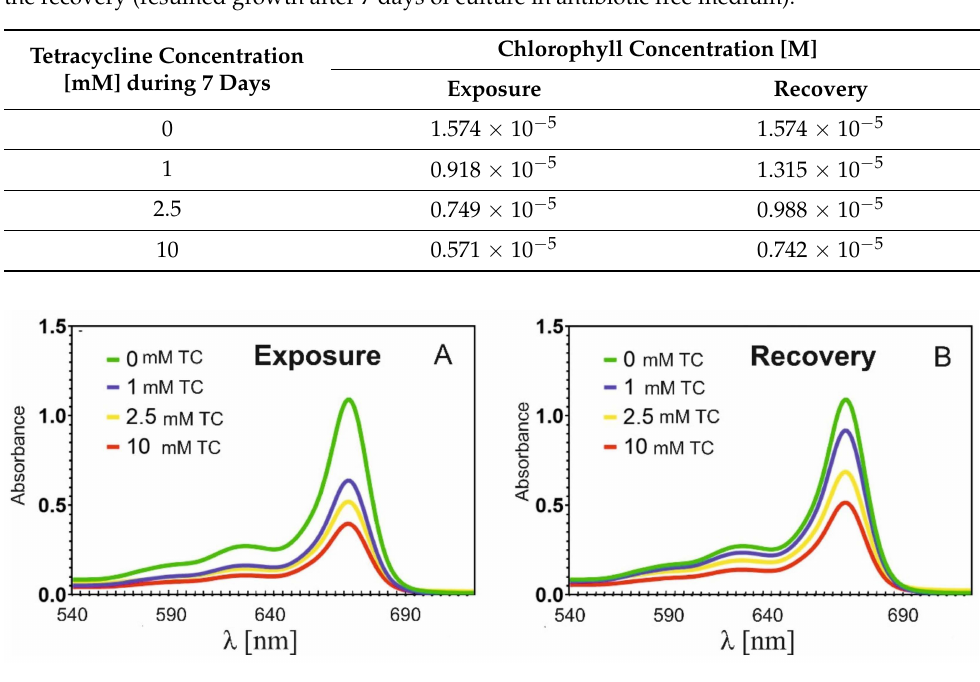
Figure 2. ( A ) Changes in absorption spectra of chlorophyll in Lemna minor subjected to tetracycline treatment and ( B ) in the recovery phase (1 week of growth in a tetracycline-free